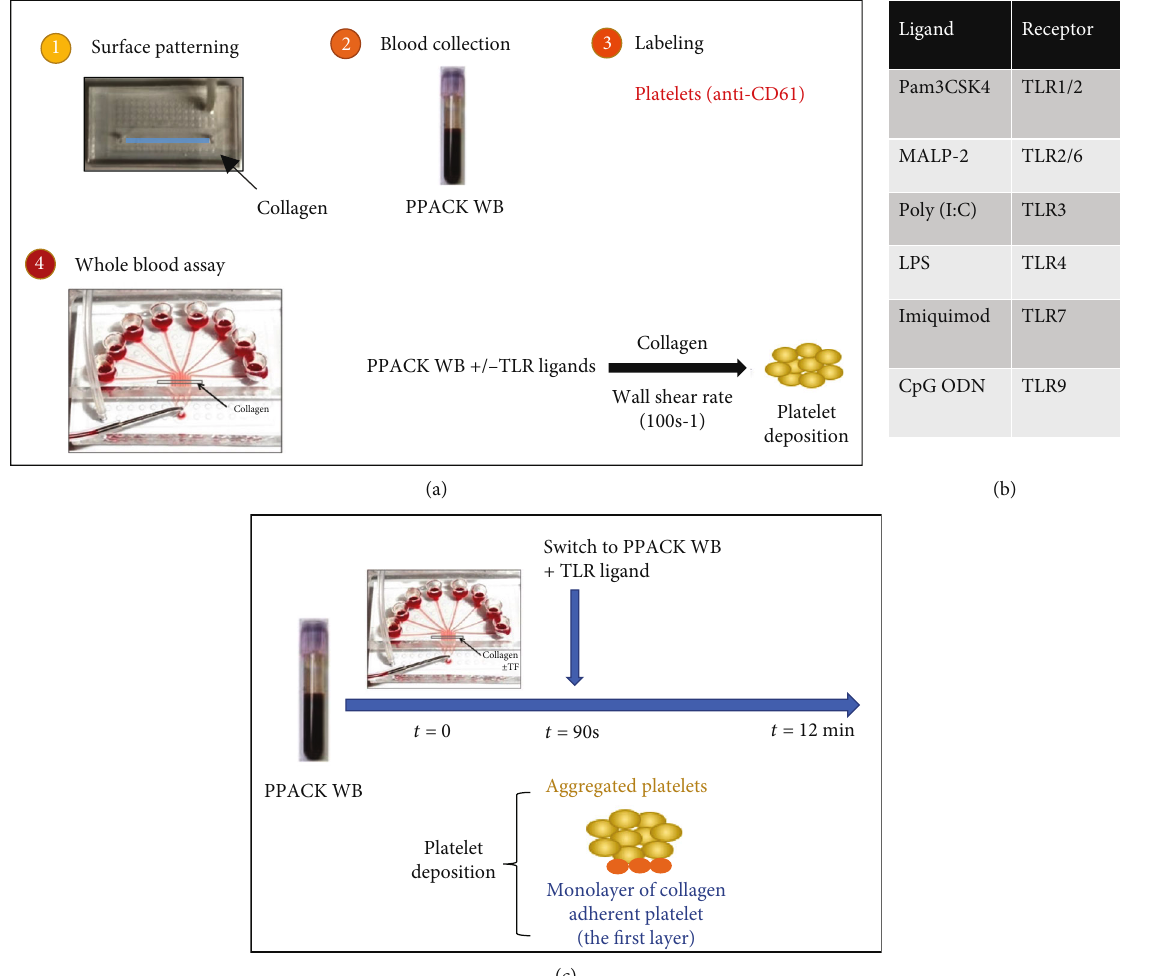
Figure 1: Micro fl uidics assay, TLR ligands, and switching experiment. Collagen surfaces were patterned on glass slides using single channel patterning devices, then PPACK WB was collected from healthy donors, platelets were labeled with anti-CD61, and actual fl ow assay were carried out in 8-channel devices (a). TLR ligands and their corresponding TLRs are listed in a table (b). For switching experiment, setting up procedures are same as the fl ow assay, experiments were running with control condition WB for the fi rst 90s, then switch to the WB with TLR ligands. Monolayer of collagen adherent platelet was formed for the fi rst 90s, then platelets from WB with TLR ligands will aggregate on the fi rst platelet